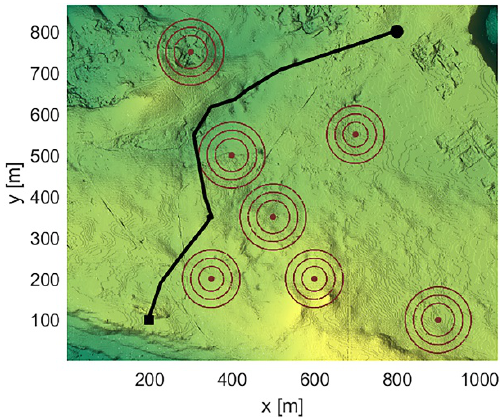
Figure 4. Top view of the path generated by the PSO algorithm.